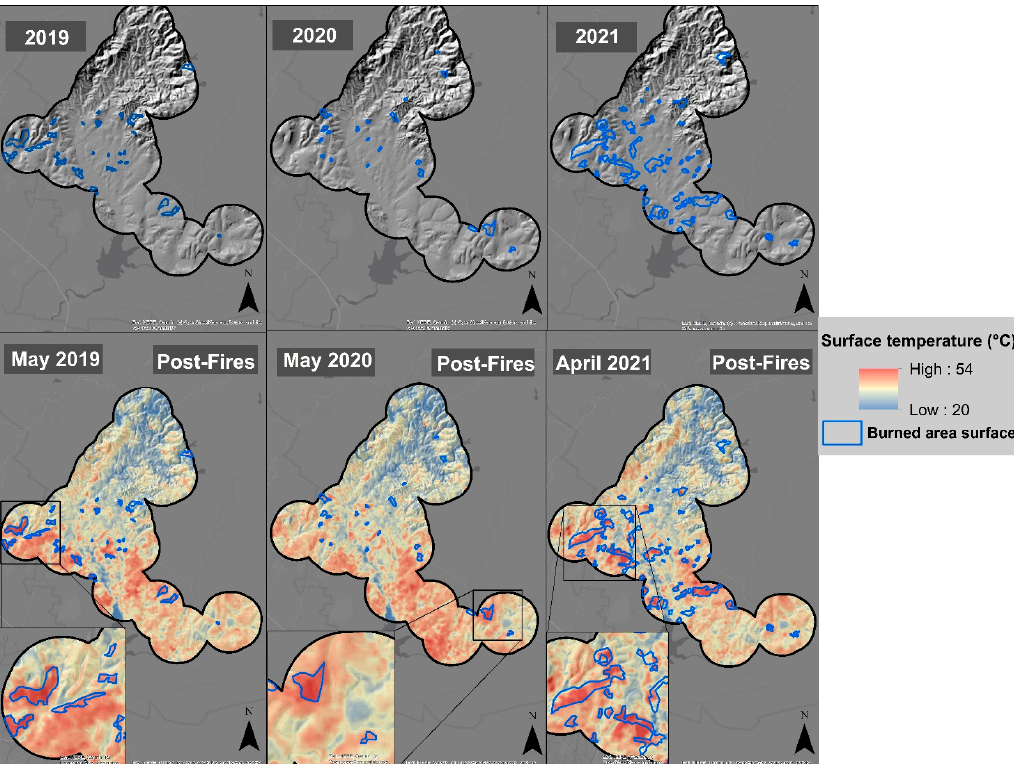
Figure 4. Distribution of burned areas and LST range at the MACG. As a result of the Getis & Ord spatial autocorrelation analysis, clusters of hot spots and cold spots were obtained (Figure 5). The hot spots in the southern part of the study area mainly overlapped with the burned areas, especially in 2021, which was the year with the largest burned area. According to the results of the Tukey post-hoc analysis (Table A3, Appendix A), there is a significant difference between the mean LST of the non-burned areas and the areas identified as hot spots, which also spatially overlap with the burned areas for the post-fire years 2019, 2020, and 2021.